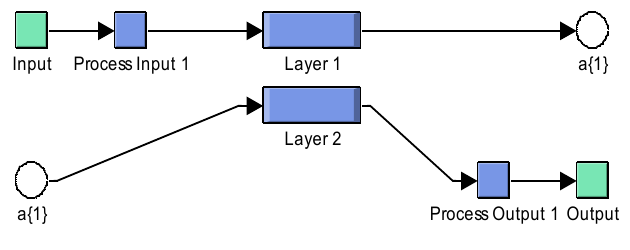
Figure 12. FNN controller.